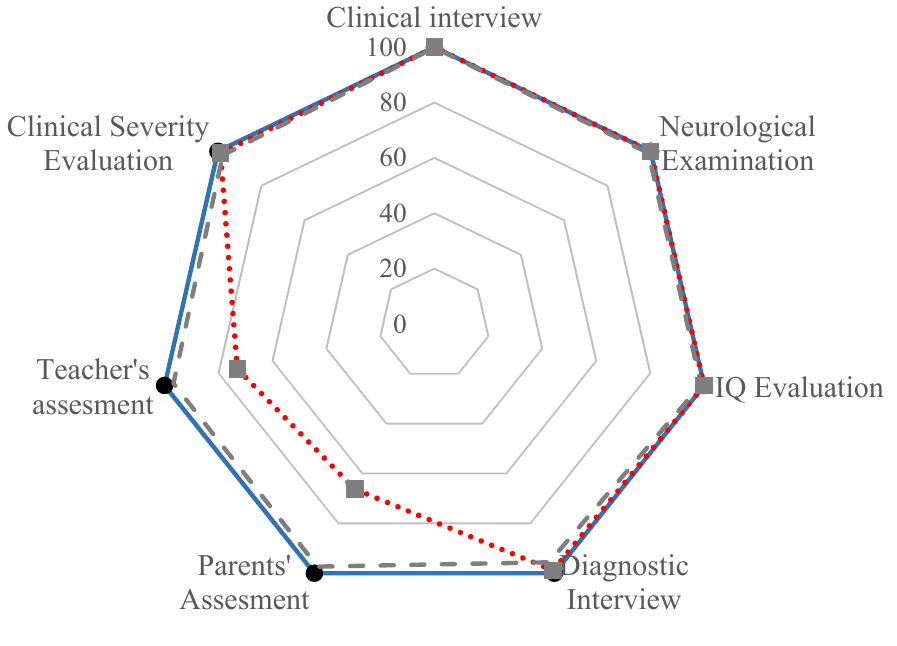
Figure 2. Rate of completeness levels based on data inputted in the registry.